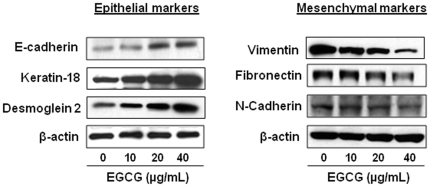
Treatment of melanoma cells with EGCG results in mesenchymal-to-epithelial transition.Treatment of A375 cells with EGCG for 24 h enhances the levels of epithelial biomarkers in the cells, such as, the levels of E-cadherin, keratin-18 and desmoglein 2. Simultaneously the levels of mesenchymal biomarkers in melanoma cells, such as, vimentin, fibronectin and N-cadherin were decreased dose-dependently. Western blot analysis was performed as detailed under Materials and Methods. Representative blots are shown from three independent experiments with similar results.